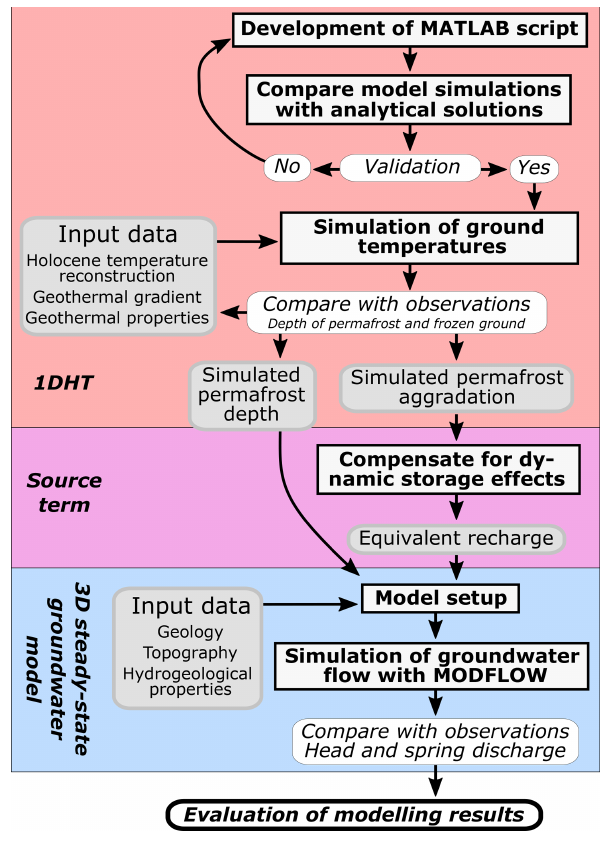
Figure 4. Schematic overview of the inner workings of the decou- pled heat and groundwater model. Model setup, calculations and algorithms are indicated with sharp corners and bold text. Valida- tion and comparison of simulations and observations are indicated with round corners and italics. Input and output data are indicated with rounded corners, grey background and normal